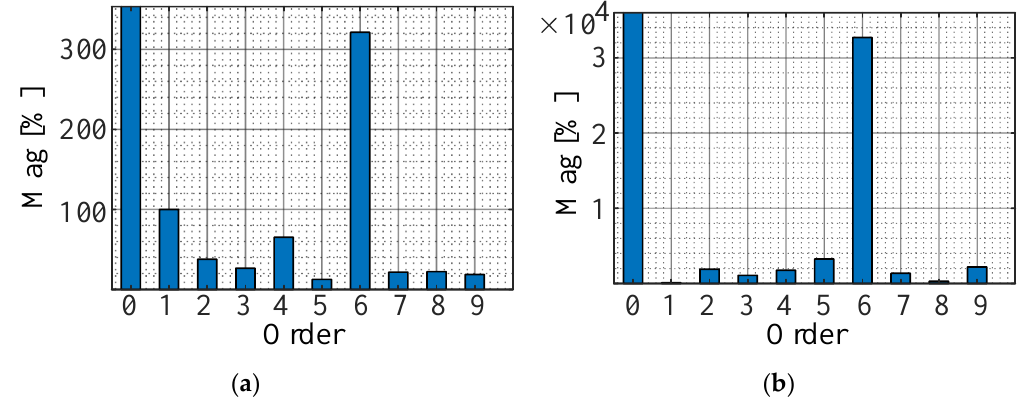
In order to reduce the 6th harmonic content in i d and i q , in this paper, a 6th harmonic resonance controller G R ( s ) is added to the current loop controller, and the expression of G R ( s ) is as follows: